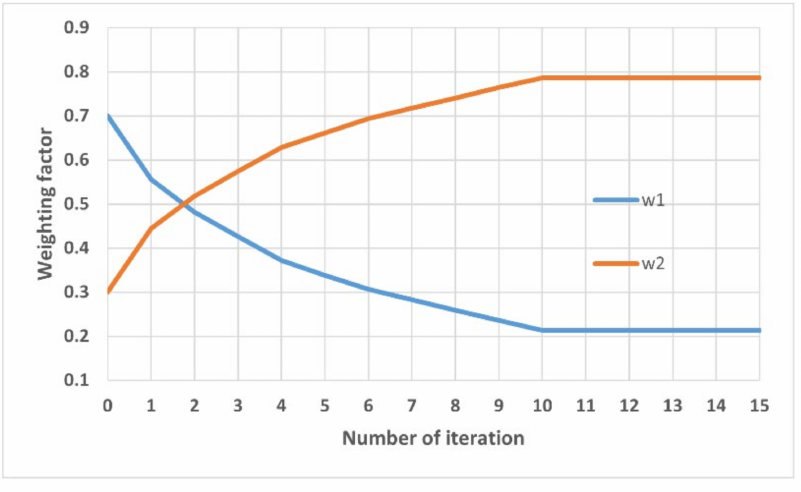
Figure 5. The result of estimation (initial value is ( w 1 , w 2 ) = (0.7, 0.3) target value is ( w 1 , w 2 ) = (0.2, 0.8)).